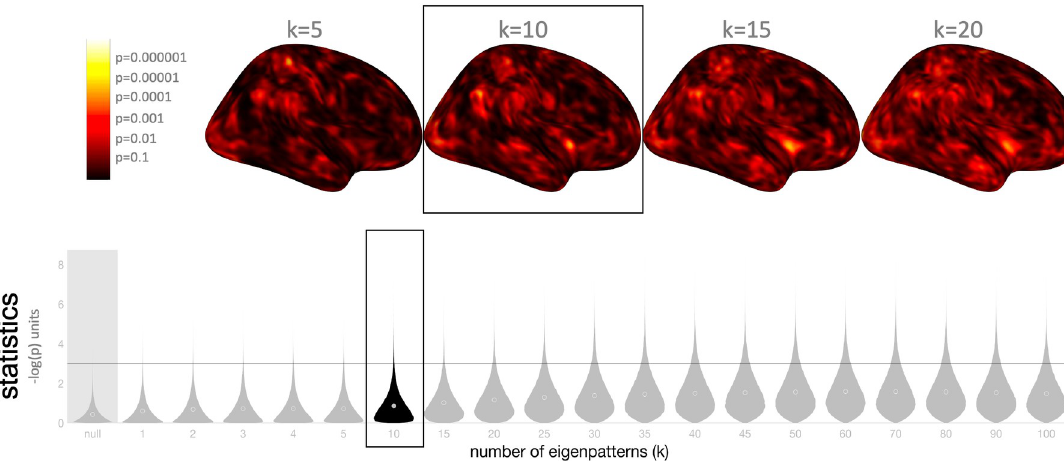
Fig 3. Selecting different number of fc-MVPA eigenpatterns. Difference in fc-MVPA statistic parametric maps evaluating gender differences in connectivity, when varying k , the number of fc-MVPA eigenpatterns used in the analysis, from k = 1 (left) to k = 100 (right). For reference, the original results shown in Fig 2 used k = 10 (highlighted here inside black box). Top : Statistic parametric maps with color coding showing voxel-level -log 10 (p) values for four different choices of k (from 5 to 20). The results show consistent statistic parametric maps across different k values. Bottom : Distribution of fc-MVPA statistics across all gray matter voxels with k ranging from 1 to 100, compared to null hypothesis distribution (shown in leftmost ‘null’ histogram). The results indicate high sensitivity across the entire range of evaluated k values, with sensitivity peaking at around k = 50 (close to a 4:1 ratio in subjects to eigenpatterns) for detecting widespread gender effects in this dataset.